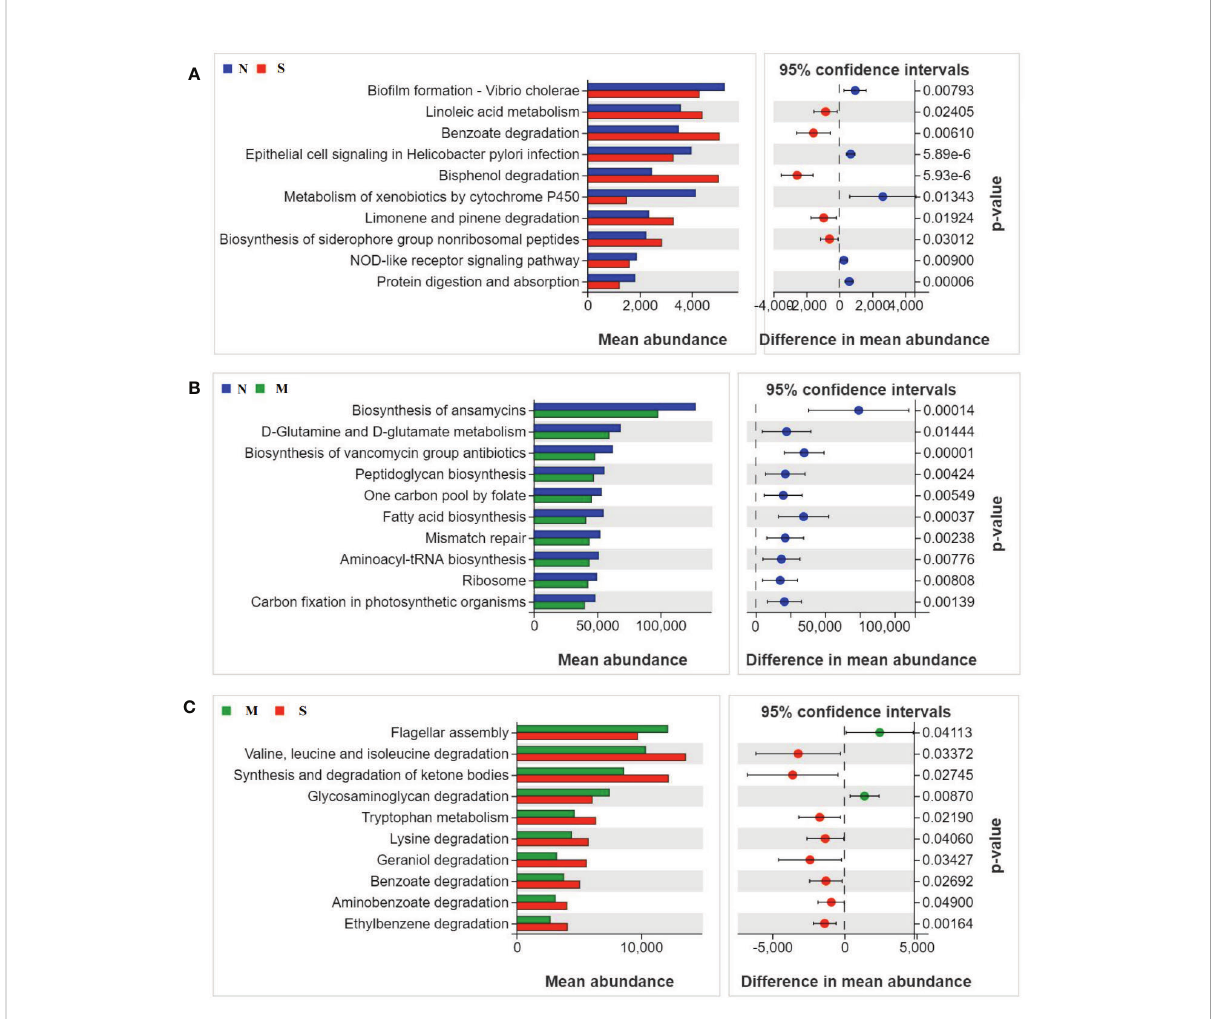
FIGURE 4 Oral microbial functional dysbiosis in metabolism pathways. Differential KEGG pathways were analyzed using PICRUSt 2, and PCoA analysis was conducted for the three groups. The top 10 signi fi cant differences between S group and N group (A) , M group and N group (B) , and S group and M group (C) were presented